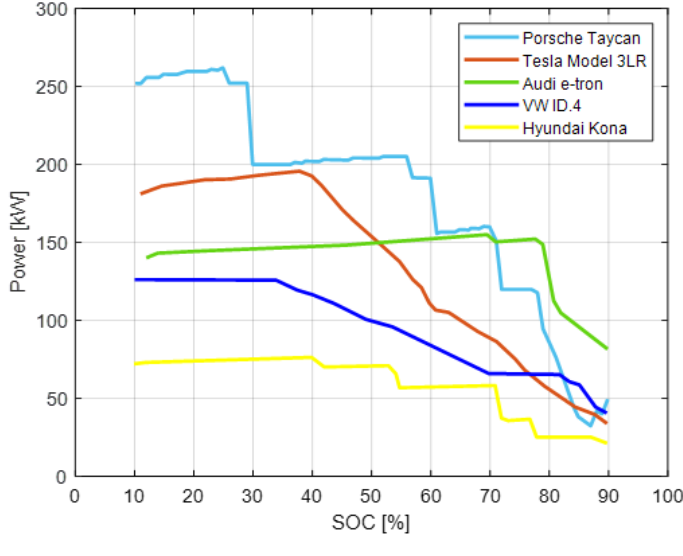
Figure 4. EV charging curves at 300 kW chargers [35].